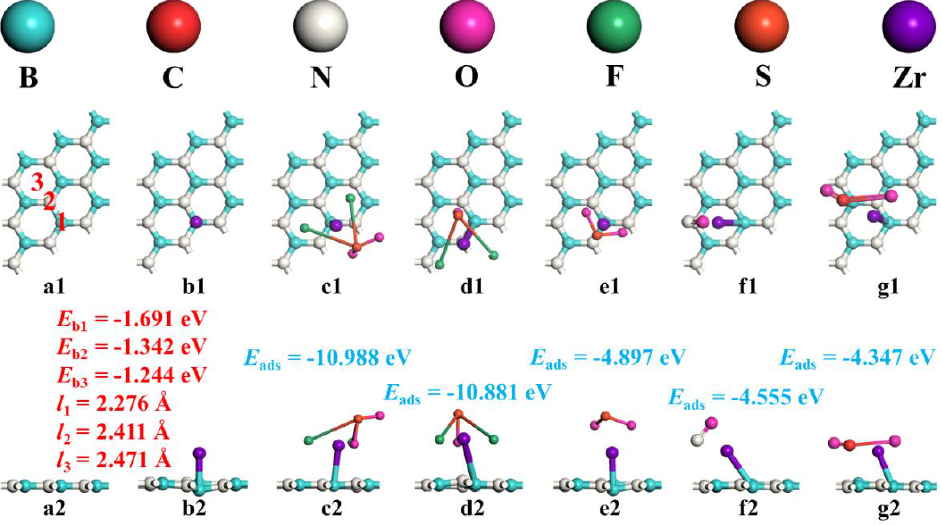
Figure 1. The geometric structures of ( a1 , a2 ) h − BN monolayer, ( b1 , b2 ) Zr − BN monolayer, ( c1 , c2 ) SO 2 F 2 adsorption system, ( d1 , d2 ) SOF 2 adsorption system, ( e1 , e2 ) SO 2 adsorption system, ( f1 , f2 ) NO adsorption system, ( g1 , g2 ) CO 2 adsorption